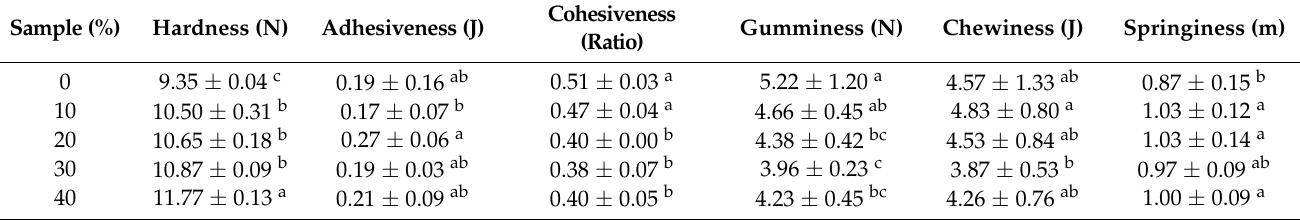
Table 3. Effect of different additions of white kidney bean flour on the textural properties of the